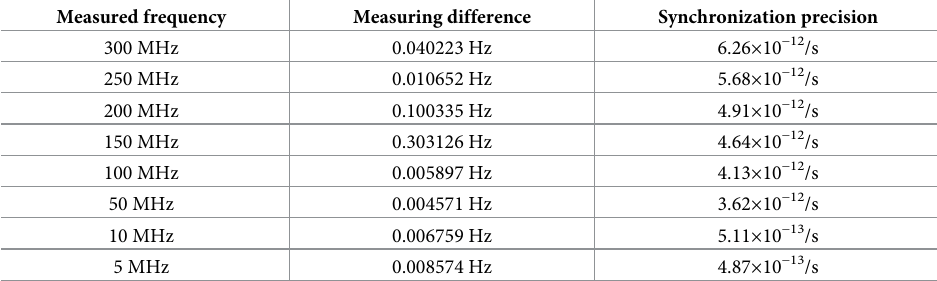
S1 Table. Frequency synchronization detection results with the same source.